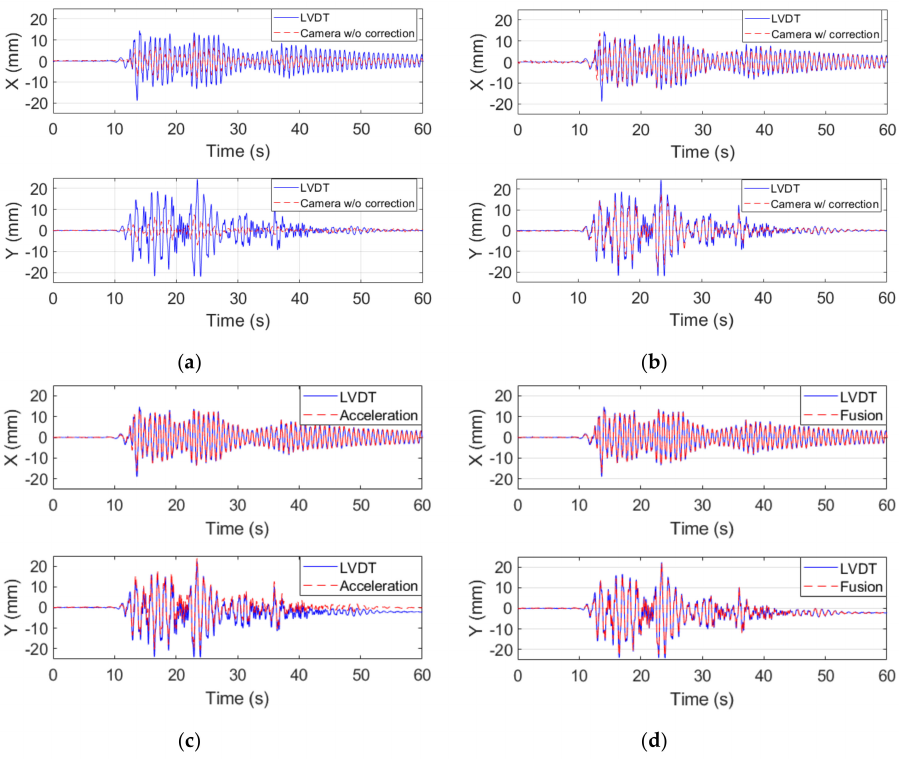
Figure 11. Time histories of interstory drift during the El Centro earthquake excitation with PGA of 250 gal measured by: ( a ) the camera without correction; ( b ) the camera with correction; ( c ) acceleration; and ( d ) the camera fused with the accelerations. (upper: X-direction and lower: Y-direction). Using the maximum absolute fused interstory drifts during the earthquake excitations, the damage level after the excitation of each earthquake was estimated according to the thresholds provided in the HAZUS-MH technical manual. The estimated maximum interstory drift values using the camera without correction, the camera with correction, the accelerometers, and the camera fused with the accelerometers are listed in Table 1. The estimated damage levels using the LVDTs are also listed in Table 2 as references. Evidently, most of the damage levels estimated using the camera without correction were underestimated, and even the moderate damage level was underestimated as safe after the excitation with a PGA value of 150 gal. After correction using the PDP method, most of the damage levels estimated using the camera were identical to the reference ones, except that the damage level after the excitation with a PGA of 150 gal was estimated as light damage, whereas it should have been estimated as moderate damage. Finally, all the damage levels estimated using the fused interstory drifts were identical to the reference